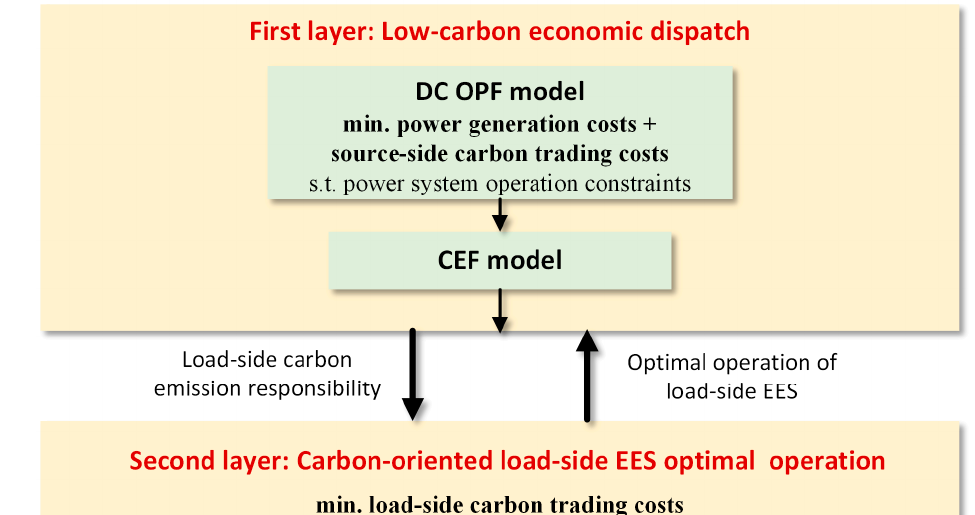
Figure 1. Hierarchical model framework.